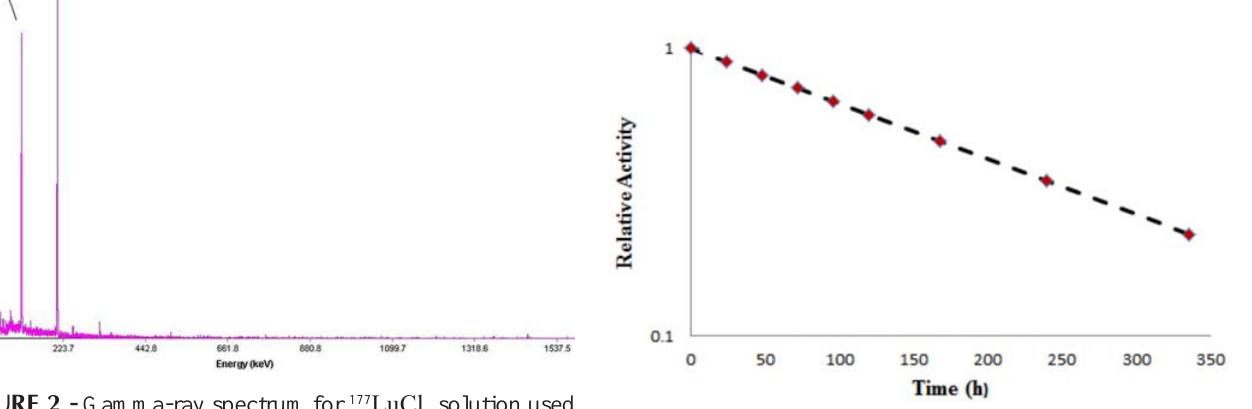
FIGURE 4 - ITLC chromatograms of 177 LuCl solution (right) using Whatman No.